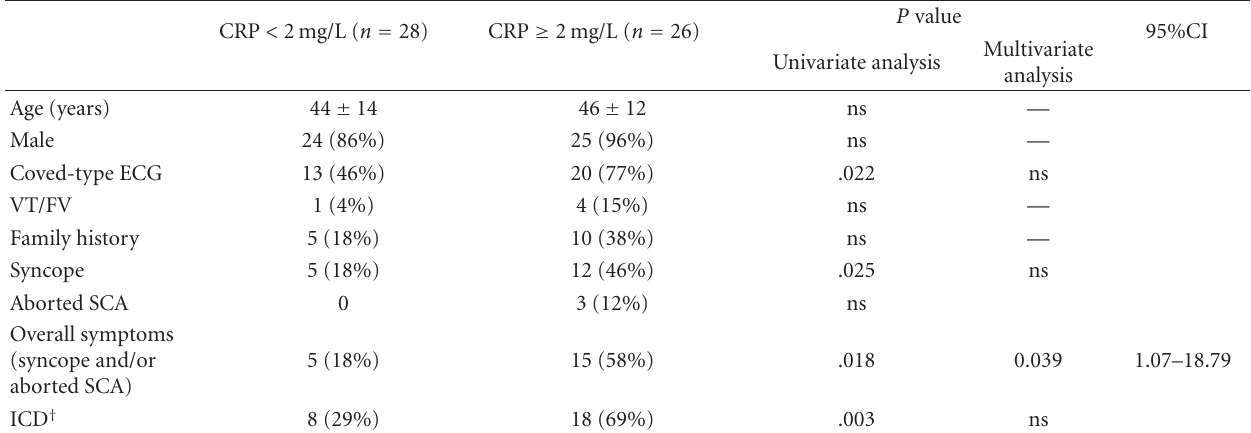
Table 2: Demographic and clinical characteristics of the Brugada patients with CRP < or ≥ 2